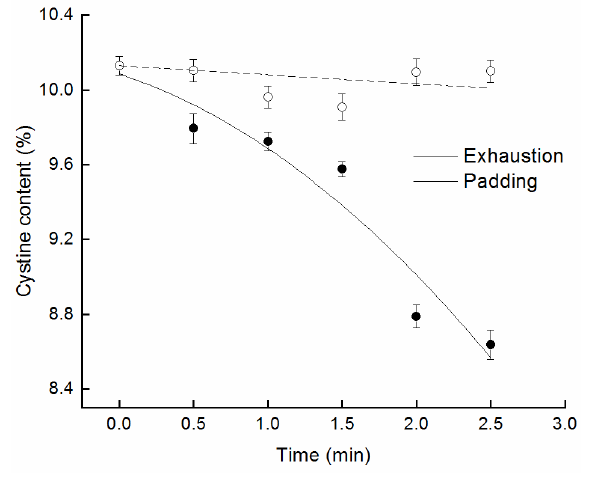
Figure 5. Effects of different processes on cysteine content.